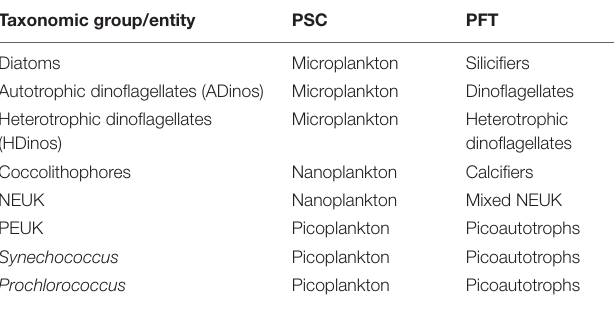
TABLE 2 | Relation between taxonomic group or entity, phytoplankton size classes (PSCs), and phytoplankton functional groups